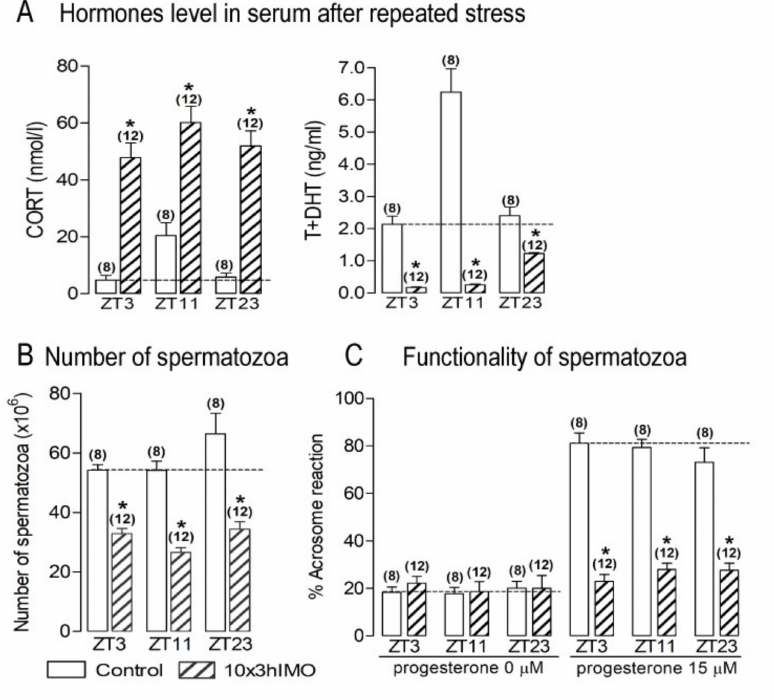
Figure 2. Repeated stress by immobilization (10 × 3hIMO) decreased androgen levels in circulation, together with functionality and number of spermatozoa, but increased the level of stress hormone cor- ticosterone in different time points. Repeated psychophysical stress by immobilization (10 × 3hIMO) increased the circulating ( A ) stress hormone corticosterone level but decreased the level of androgens (testosterone + dihydrotestosterone, T+DHT). ( B ) The number of isolated spermatozoa from the caudal epididymides of undisturbed (control) rats and rats subjected to repeated immobilization stress, for 3 h for 10 consecutive days (10 × 3hIMO) in different periods during 24 h (from ZT0 to ZT3, from ZT8 to ZT11, and from ZT20 to ZT23; ZT0 was the time when the light turned on). ( C ) Sper- matozoa functionality, presented as a % of acrosome-reacted spermatozoa, isolated from unstressed and repeatedly stressed (10 × 3hIMO) rats. After the capacitation, spermatozoa were stimulated with progesterone (PROG 15 µ M) together with spermatozoa that were not treated with progesterone (PROG 0 µ M). Acrosome-reacted spermatozoa were observed as the spermatozoa without the blue staining in the acrosome region, while blue staining in the acrosome region of the head of spermatozoa indicated intact acrosome. Data bars are mean ± SEM values of two independent in vivo experiments (n = number of rats). Statistical significance was set at level p < 0.05: * vs. control group of the same time